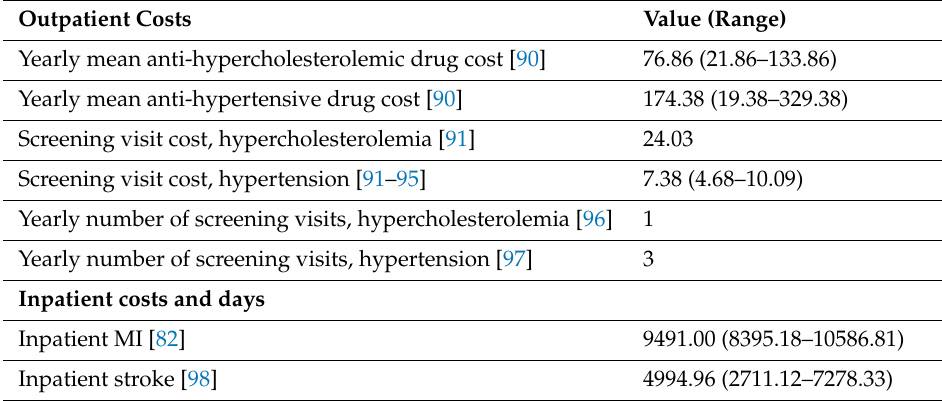
Table 3. Costs and